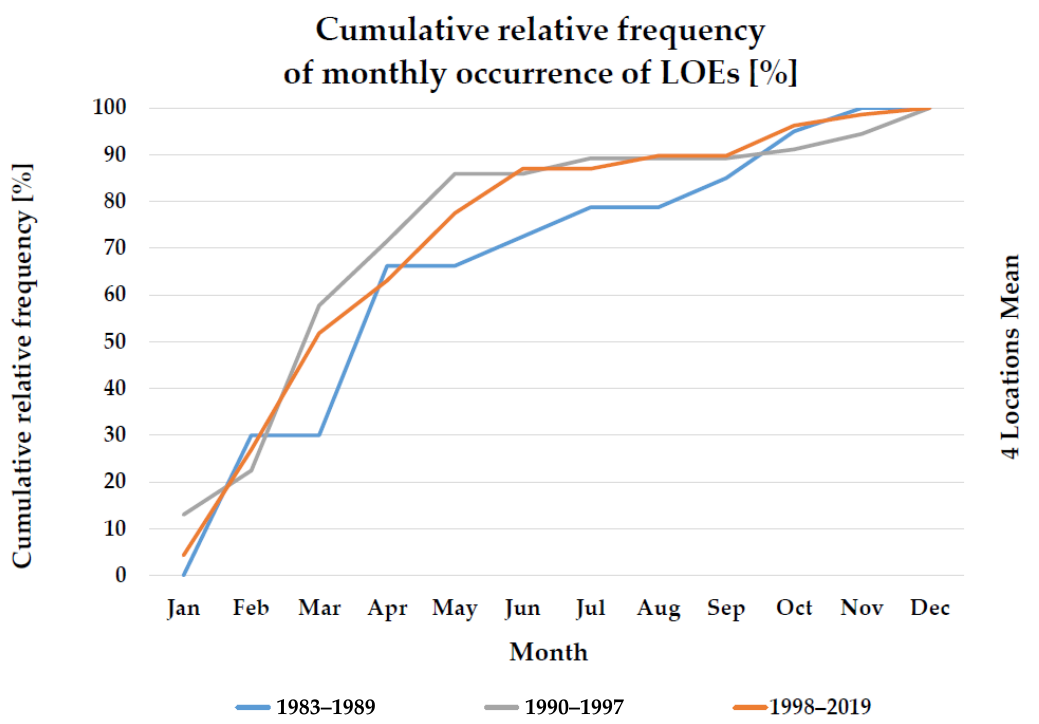
Figure 7. Mean cumulative relative frequency of monthly occurrence of LOEs during the subperiods T1 (1983–1990), T2 (1990–1997), T3 (1998–2019) (4-location